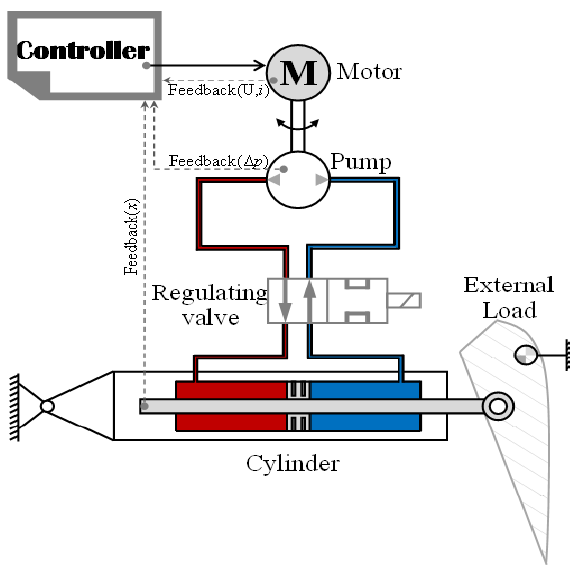
Figure 1. Schematic diagram of an electrohydrostatic actuator (EHA). A typical servo motor model is the brushless DC motor (BLDCM). In this case, the three windings are in a Y-connection. Assume that the parameters of each winding stay the same and the magnetic field between the stator and the rotor is a regular trapezoidal